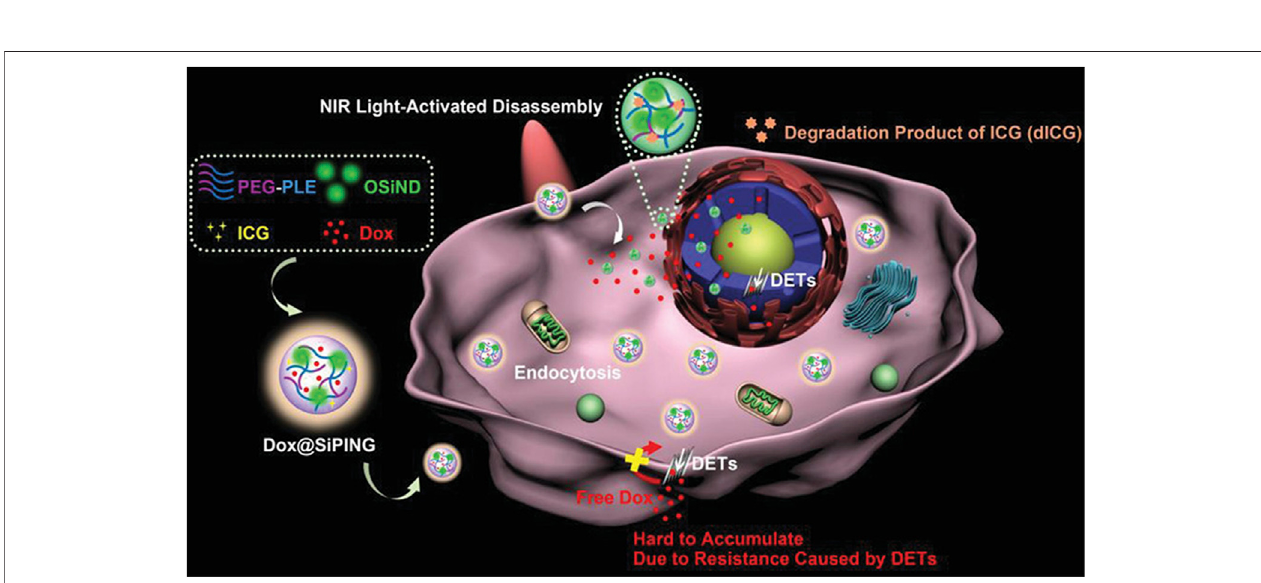
FIGURE 11 | Schematic diagram of the nanogel structure. Such a structure can enhance cellular uptake and nuclear delivery of drugs, thereby contributing to the effective circumvention of multidrug resistance in cancer (Chen et al., 2019).